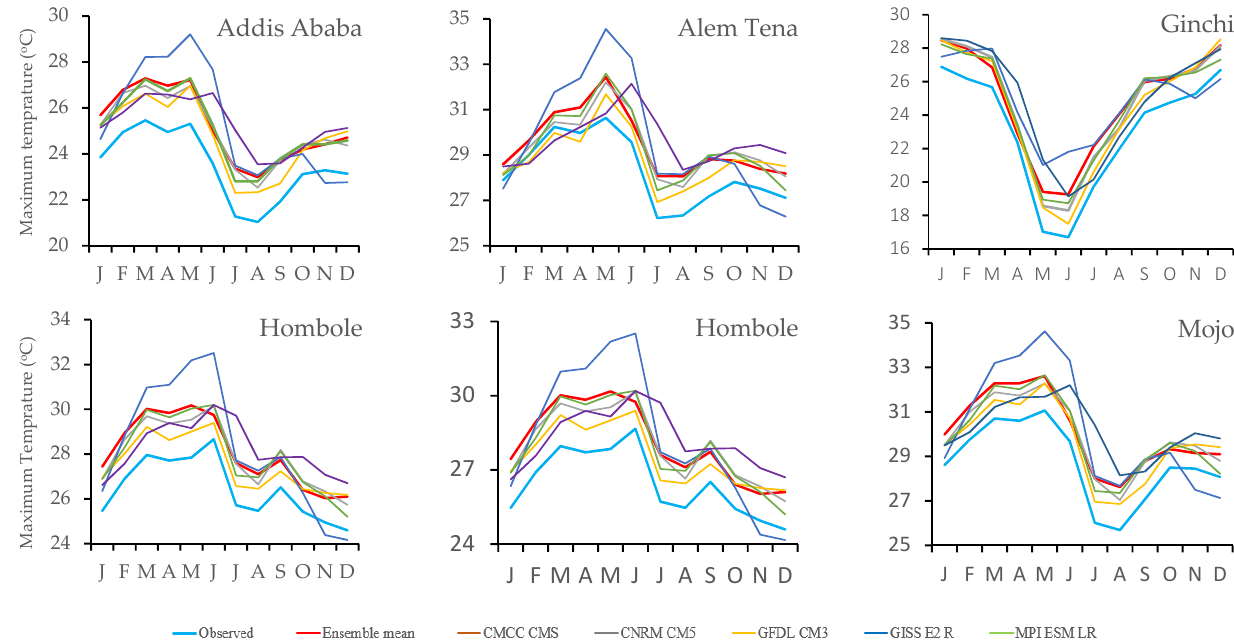
Figure 3. Mean monthly minimum temperature for baseline and different GCMs.